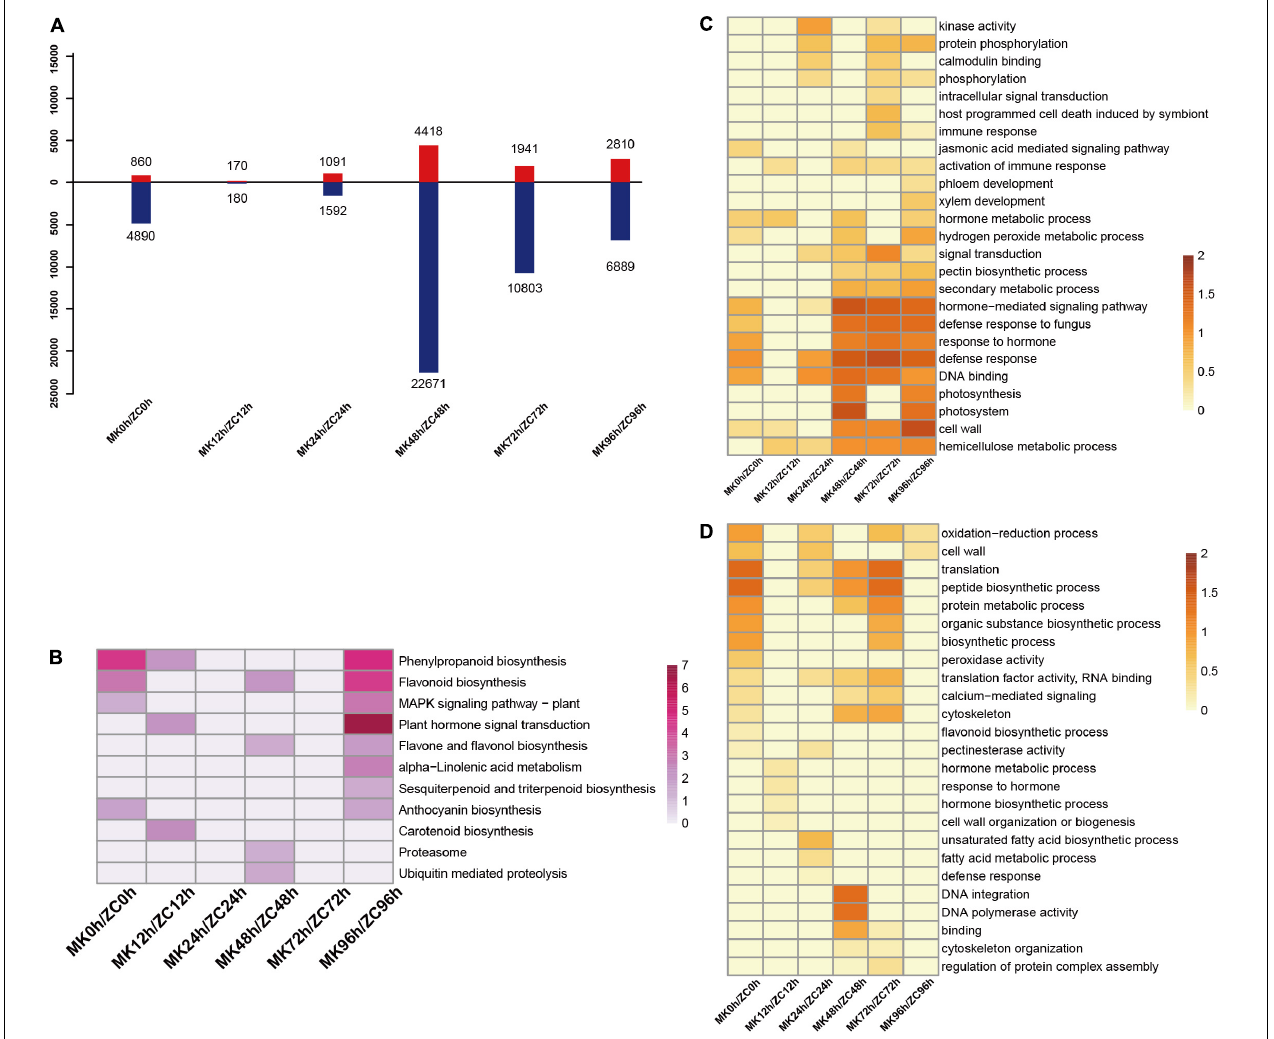
FIGURE 2 | Statistical and functional analysis of DEGs between MK and ZC. (A) Number of upregulated and downregulated DEGs at the same time points between MK and ZC. (B) KEGG term enrichment of DEGs from same time points between MK and ZC. (C,D) GO term enrichment of upregulated (C) and downregulated (D) DEGs in pairwise comparisons. The data were calculated by –log 10 ( p